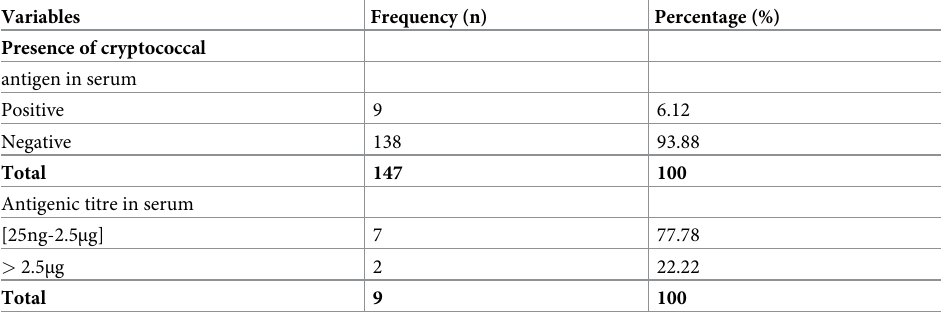
Table 4. Distribution of the population according to prevalence of cryptococcal antigenemia and to antigenic titre.